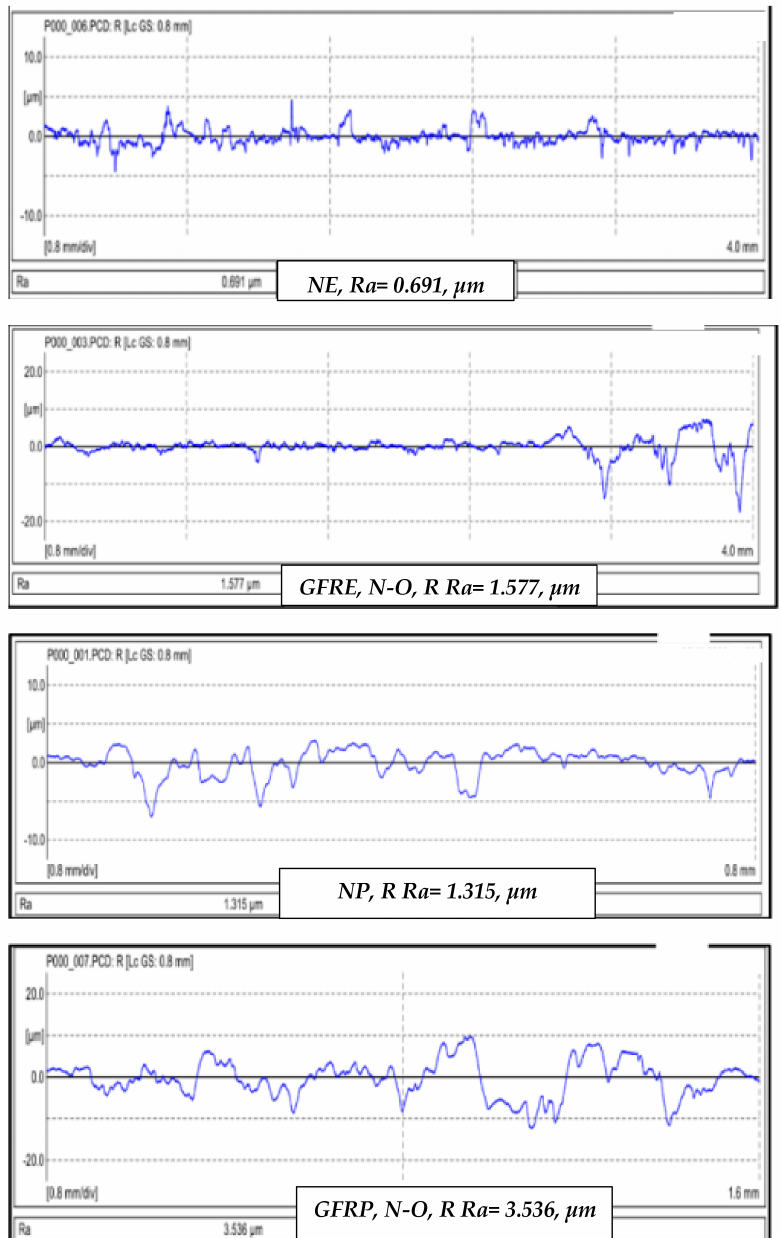
Figure 8. Sample roughness profiles Ra of selected materials at different operating